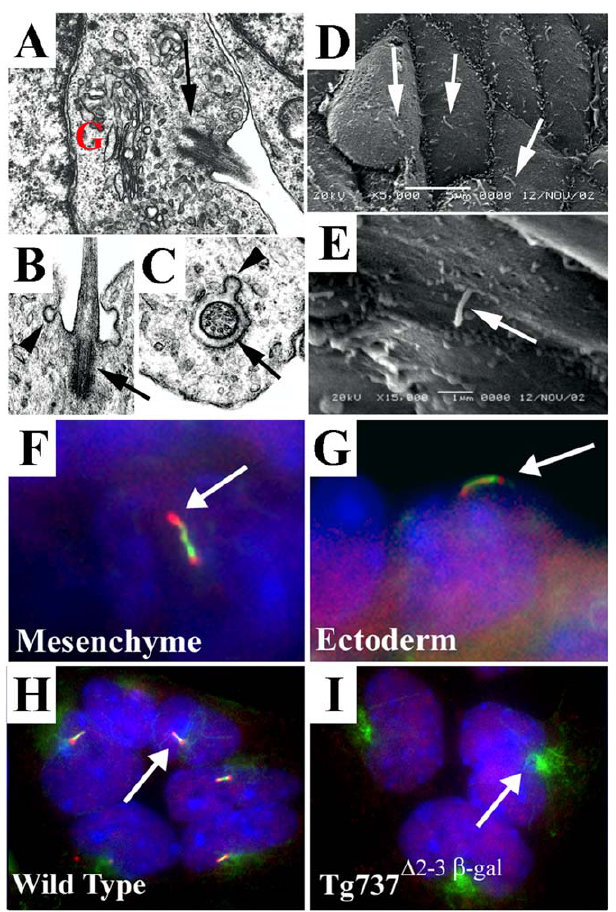
Figure 1. Cilia Are Present on Both Mesenchymal and Ectodermal Cells of the Developing Limb (A–C) Transmission electron micrographs of limb bud mesenchyme show cilia (arrows) closely associated with the Golgi apparatus ( ‘‘ G ’’ ). The cilia exhibited a 9 þ 0 structure (C) and are often found in deep depressions in the membranes (B). Frequently, small vesicles are observed fusing or budding with the surrounding membrane (arrowheads in [B] and [C]). (D and E) Scanning electron micrographs of the limb ectoderm show a single cilium (arrows) on nearly all ectodermal cells. (F and G) Immunolocalization of Polaris (red) and acetylated a -tubulin (green) in frozen sections of limb buds shows that Polaris concentrates at the base and tip of the axoneme in both mesenchymal (F) and ectodermal (G) cells. Nuclei are blue. (H and I) InprimaryculturesofcellsisolatedfromE11.5limbbuds,cilia(arrowin H) are also present when visualized with anti-acetylated a -tubulin (green) and anti-Polaris(red)antisera(H).Ciliaareabsentoncellsisolatedfrom Tg737 D 2–3 b -gal mutant limb buds (I); however, the stabilized microtubules were still evident aroundthebasalbodyregion(arrow).ThenuclearstainingforPolarisispresent in the Tg737 D 2–3 b -gal cells, indicating that it is nonspecific. Nuclei are blue. DOI: 10.1371/journal.pgen.0010053.g001